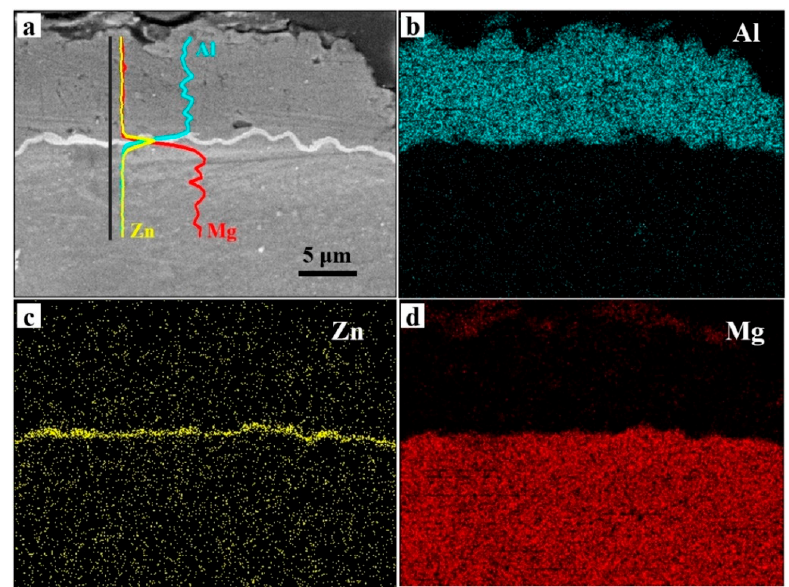
Figure 3. The Energy Dispersive X-Ray Spectroscopy (EDXS) analysis of the electrodeposition Al coatings obtained on the AZ91D Mg alloy with Zn immersion, ( a ) the cross-sectional morphology, ( b ), ( c ) and ( d ) the EDXS analysis.